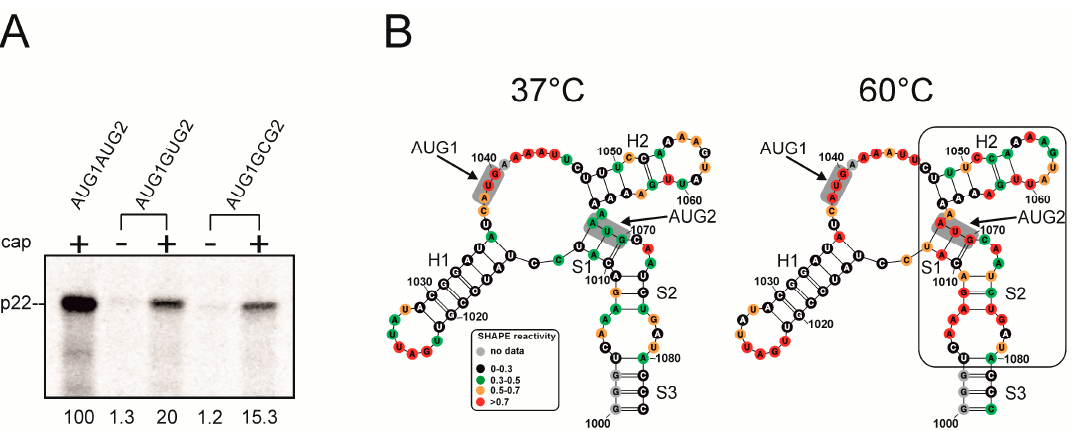
Figure 5. In vitro translation of AUG2 mutational variants of Ty1i RNA and melting profile of AUG1AUG2 RNA. ( A ) In vitro transcribed capped or uncapped transcripts were translated using wheat germ extract in the presence of 35 S-methionine. Calculated translation activity (in relation to the capped AUG1AUG2 RNA) is shown below the gel. ( B ) Melting of AUG1AUG2 RNA followed by SHAPE at 37 °C and 60 °C. Nucleotides are coloured according to their reactivity (black, green, orange, red). The segment of domain I with the strongest changes at 60 °C is boxed.